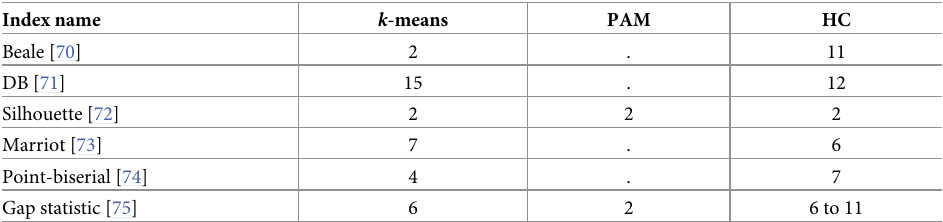
Table 5. Recommended number of